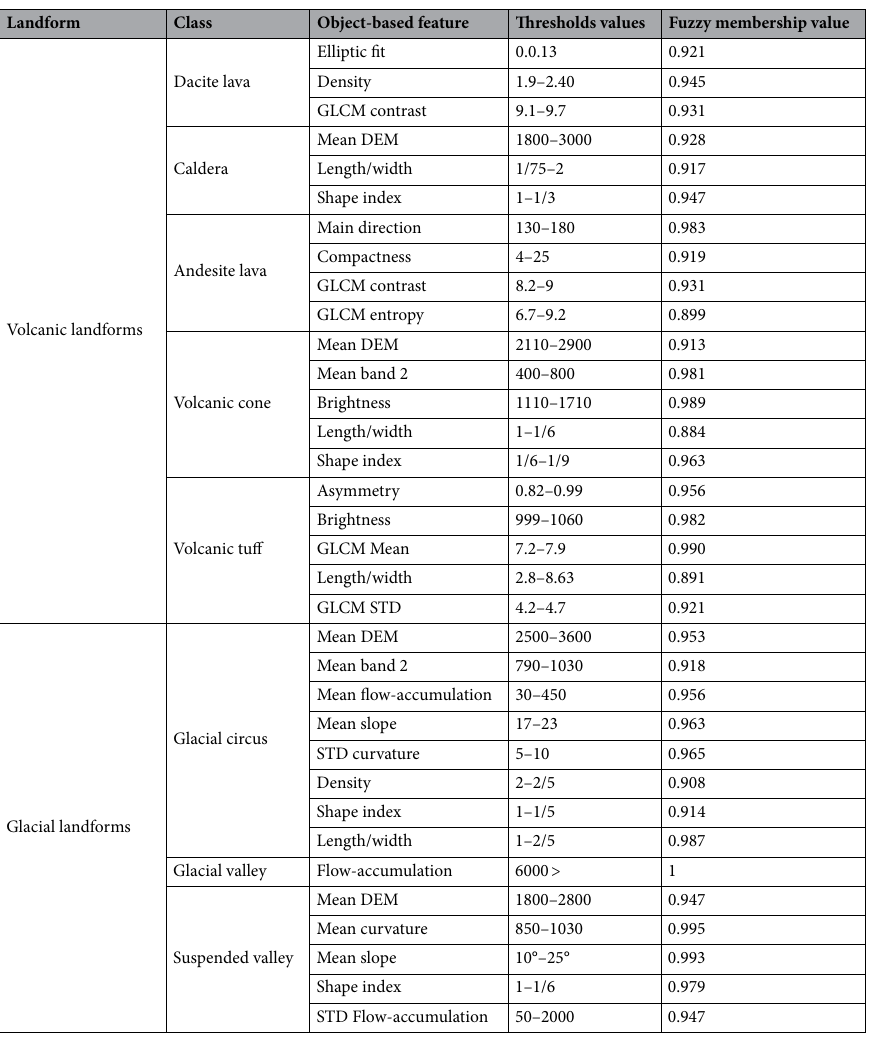
Table 5. Volcanic and glacial landforms classes and their corresponding thresholds values for object-based